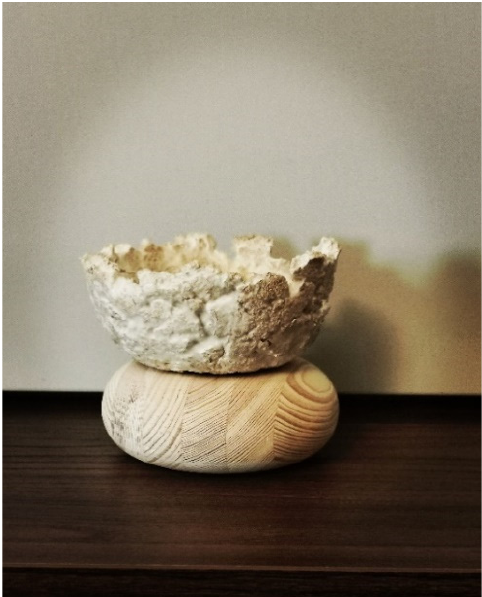
Figure 13. Finished object: mycelium-based bowl fixed to the rough-timber torus-shape base (design and photo: A. Bonenberg).